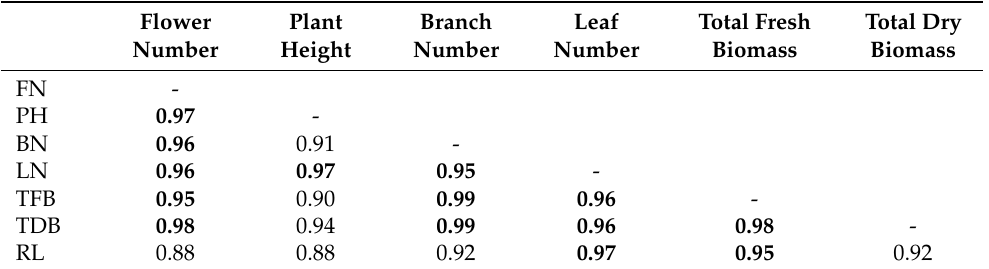
Table 5. Correlation coefficients between tested zinnia variables (significant correlations are marked in bold, p < 0.05, N = 80).